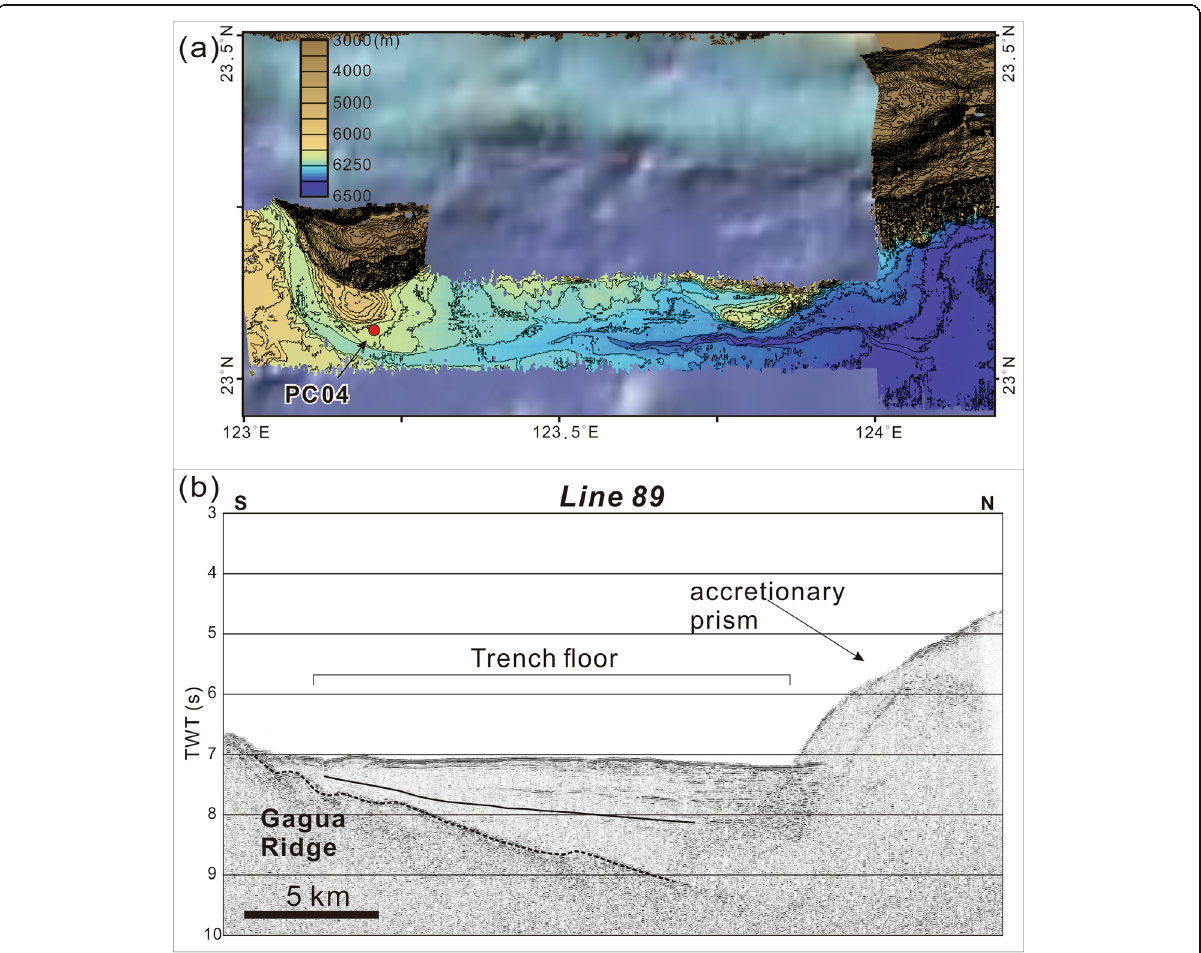
Fig. 2 a Detailed bathymetry of the southwestern Ryukyu Trench. Cores PL04 and PC04 (red circle) were drilled in the north levee of the axial channel of the Ryukyu Trench floor. b Seismic reflection profile line 89 runs roughly N-S through the study area (red solid line in Fig. 1). Depth is represented as two-way travel time